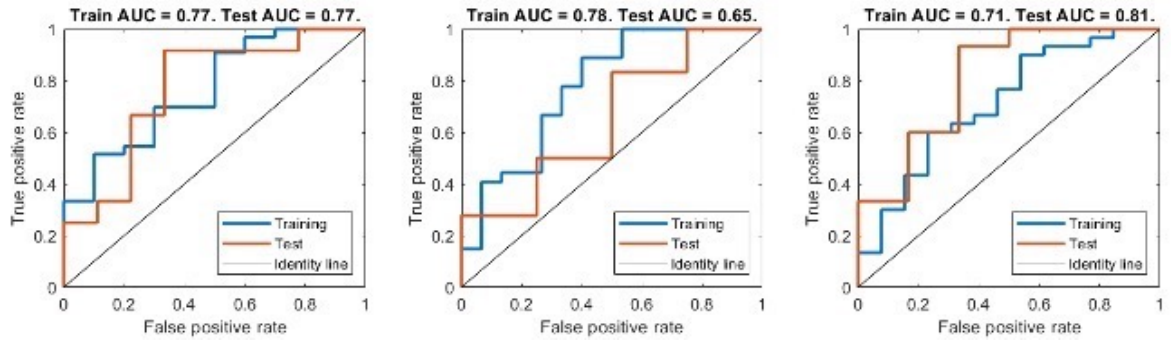
Figure 5. ROC curve for both training and test set of the best performing model. Each subplot corresponds to an iteration of the K-fold cross-validation, where the model was trained on 2 subsets of the data and tested on the third one.